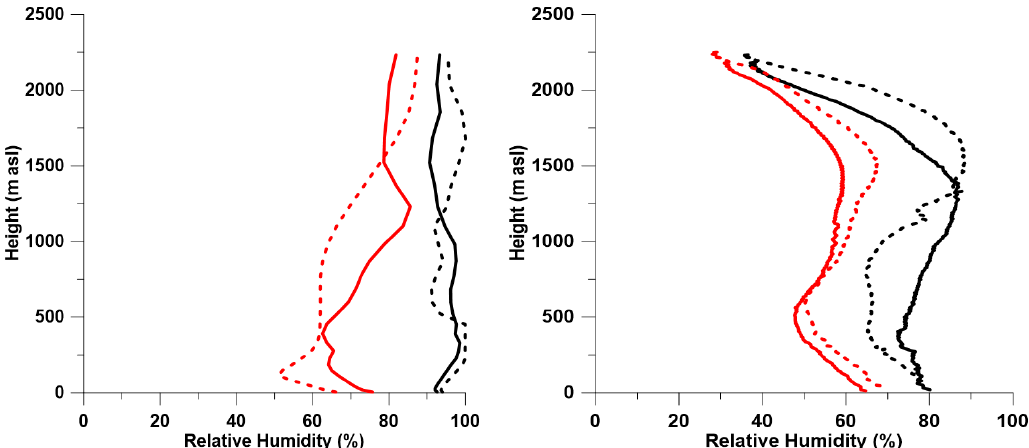
Figure 12. Model ( left ) and dropsonde ( right ) relative humidity profiles for closer to the coast at ~2033Z (red solid) and ~2059Z (red dash), and further off-shore at ~2011Z (black solid) and 2044Z (black dash) on 21 May 2015.